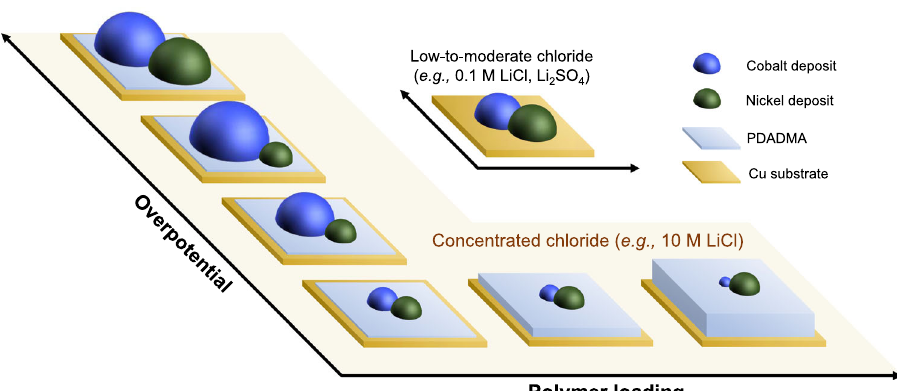
Fig. 1 A schematic representation of potential-dependent selectivity tuning enabled by synergistic electrolyte and interfacial control. In concentrated chloride, controlling applied potential and/or polyelectrolyte loading (PDADMA, poly(diallyldimethylammonium chloride)) allows to tune molecular selectivity of cobalt and nickel in